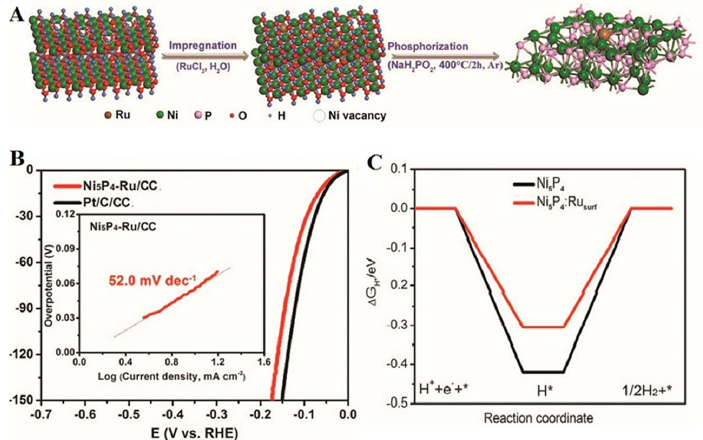
Figure 2. ( A ) Schematic illustration of the fabrication of Ni 5 P 4 -Ru. ( B ) Hydrogen evolution reaction (HER) linear scanning voltammetry (LSV) curves for the Ni 5 P 4 -Ru and Pt/C loaded on carbon cloth (CC). The inserted figure showed the Tafel plot of Ni 5 P 4 -Ru/CC. ( C ) Free energy of hydrogen adsorption on Ni 5 P 4 and Ni 5 P 4 -Ru (reprinted with permission from ref [41]. Copyright © 2020, John Wiley and Sons).